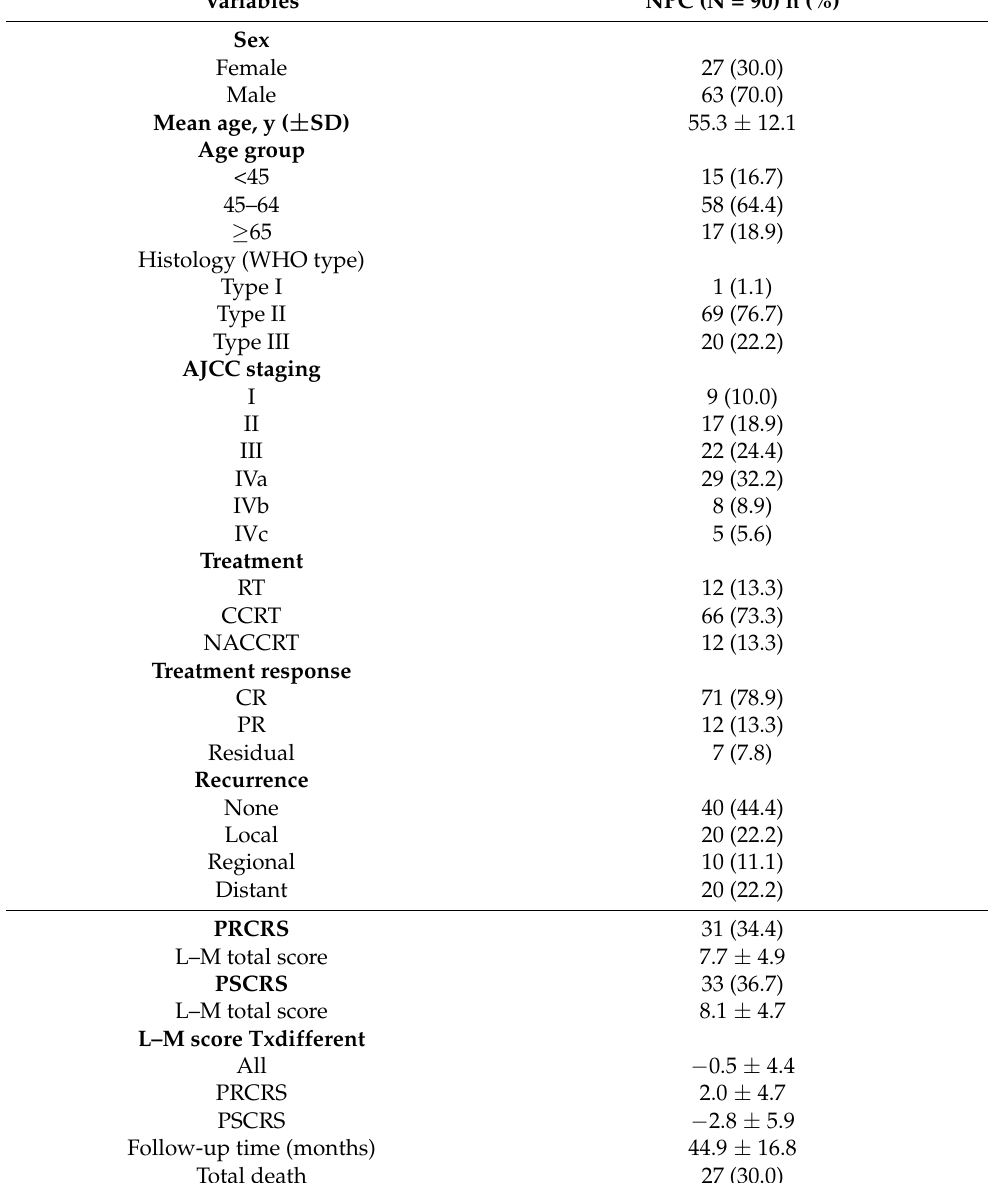
Table 1. Patient